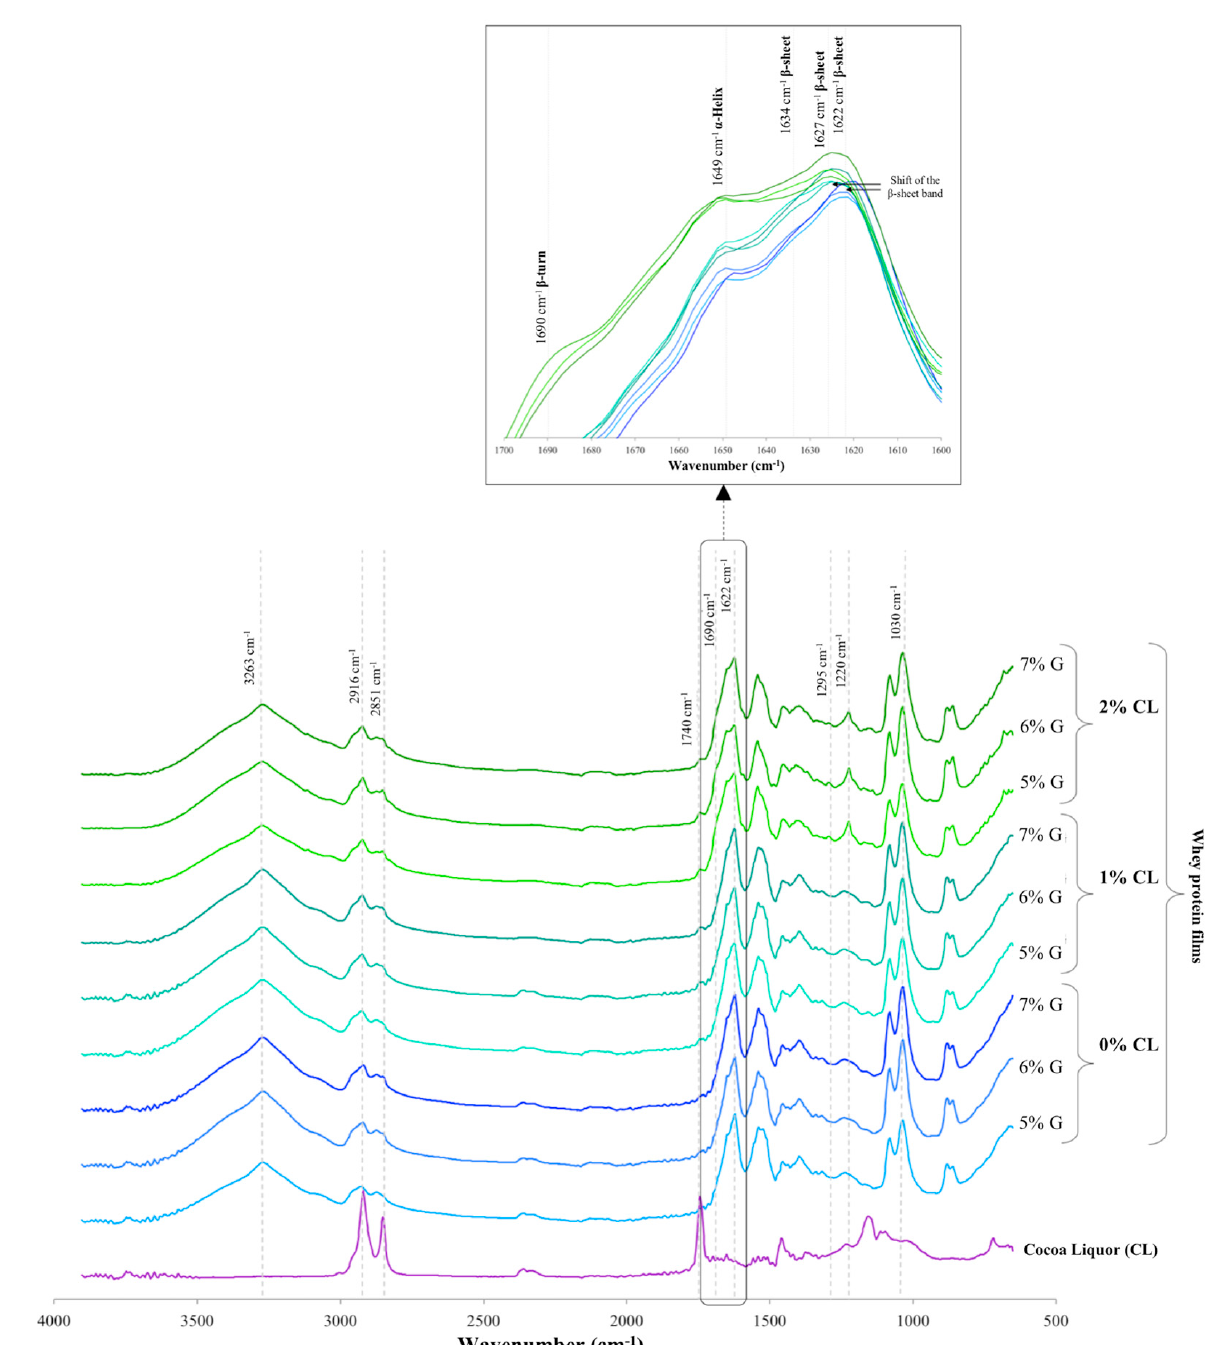
Figure 4. Comparison of FTIR absorbance spectra of the cocoa liquor and whey protein films with different cocoa liquor (CL) (0, 1, and 2%) and glycerol (G) (5, 6, and 7%) contents, indicating the most relevant absorption signals, and the signals associated with the different secondary conformations ( α -helix, β -sheet, and β -turn) in the amide I region (1700–1600 cm − 1 ) of the proteins in the films.